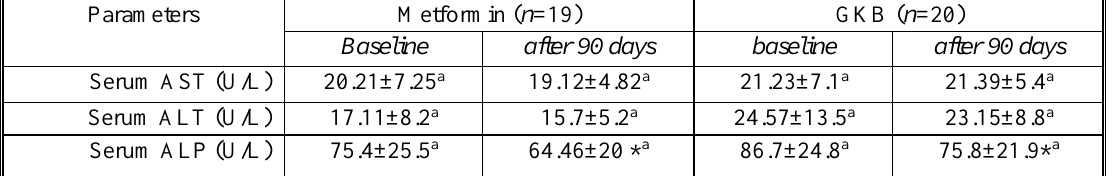
Table 2. Effect of Gingko biloba extract (GKB) on the liver function markers of patients with metabolic syndrome.